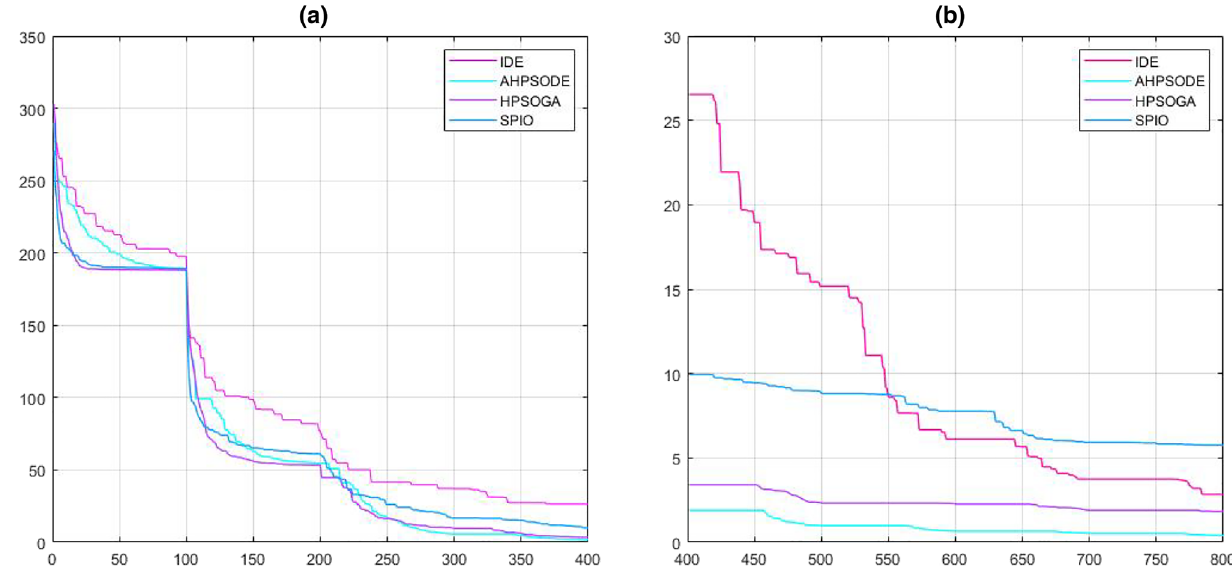
Fig. 14 a Evolution curve of all algorithms at the 1st–4th time horizon; b evolution curve of all algorithms at the 5th–8th time